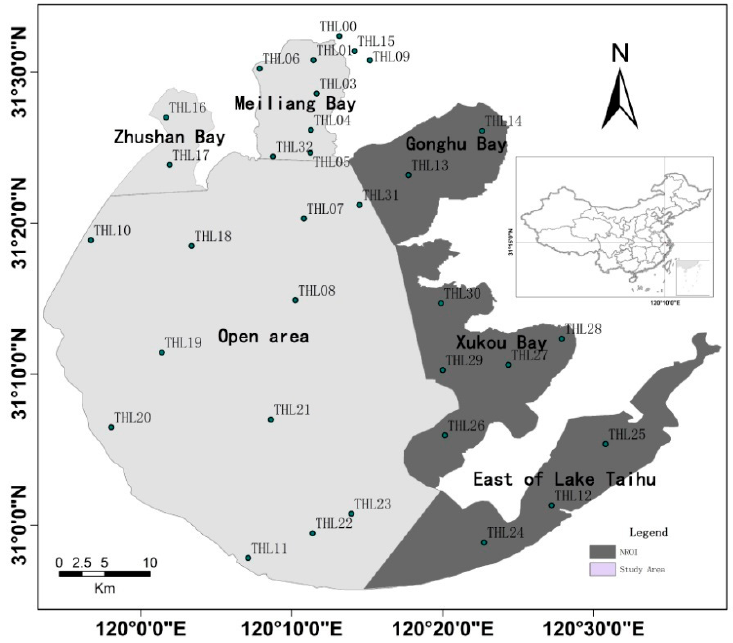
Figure 1. Maps showing location of Lake Taihu and the sampling sites. The in situ primary production were measured at two sites, THL04 (31.44583°N, 120.18883°E) and THL08 (31.24816°N, 120.10062°E), from 2005 to 2013. The in situ nutrient concentration in 2013 including total nitrogen and total phosphorus were collected from 32 sites THL00-THL32 (except THL02).